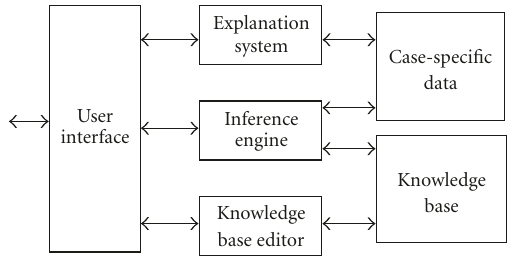
Figure 13: Block diagram of an expert